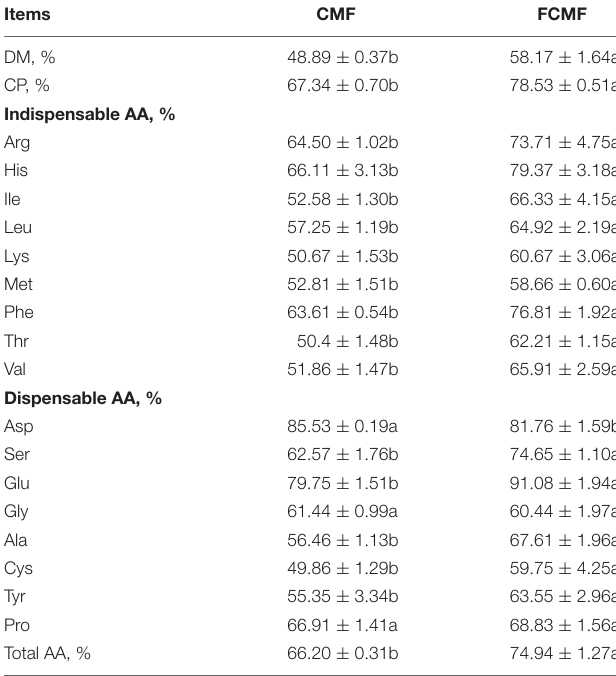
Tyr 55 . 35 ± 3 . 34b 63 . 55 ± 2 . 96a Pro 66 . 91 ± 1 . 41a 68 . 83 ± 1 . 56a Total AA, % 66 . 20 ± 0 . 31b 74 . 94 ± 1 . 27a Values were mean ± SD, n = 3. Means followed with different superscript letters (a, b) within each line are significantly different (p < 0.05). and Xanthobacteraceae increased significantly. After 36 h of anaerobic fermentation, Paenibacillus spp., Pantoea spp., and Lactobacillales were